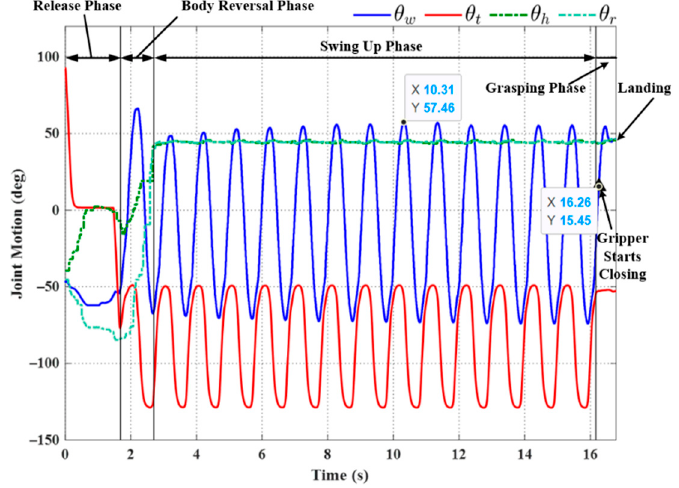
Figure 20. Experimental results: joint motion in Experiment (e).